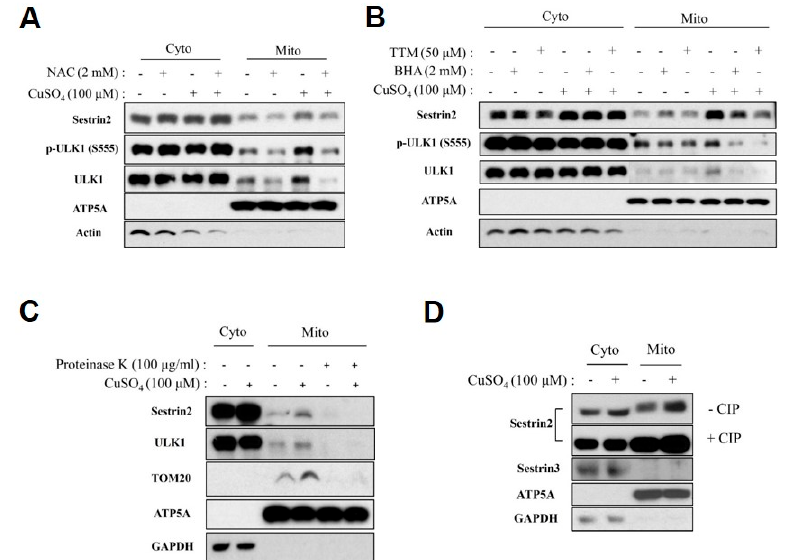
Figure 3. Phosphorylated form of Sestrin2 is associated with the outer mitochondrial membrane upon oxidative damage caused by Cu-induced ROS. ( A ) HEK293 cells were treated with 100 µ M CuSO 4 for 24 h with or without 2 mM antioxidant N-acetyl cysteine (NAC), then the cytosolic and mitochondria fractions were isolated and subjected to immunoblotting with indicated antibodies. ( B ) HEK293 cells were treated with 100 µ m CuSO 4 for 24 h with or without 2 mM butylated hydroxyanisole (BHA) or 50 µ M Cu chelator tetrathiomolybdate (TTM), then the cytosolic and mitochondria fraction was isolated and subjected to immunoblotting with indicated antibodies. ( C ) The same fractionation samples from (B) were treated with 100 µ g / mL proteinase K for 1 h to perform the mitochondria protein protection assay. 12% SDS-PAGE gel was used to detect the smaller size of proteins in immunoblotting. ( D ) The same fractionation samples from (B) were treated with or without calf intestinal alkaline phosphatase (CIP) for 1 h and assayed through immunoblotting. 8% SDS-PAGE gel was used to ensure enough separation shift for phosphorylated form of